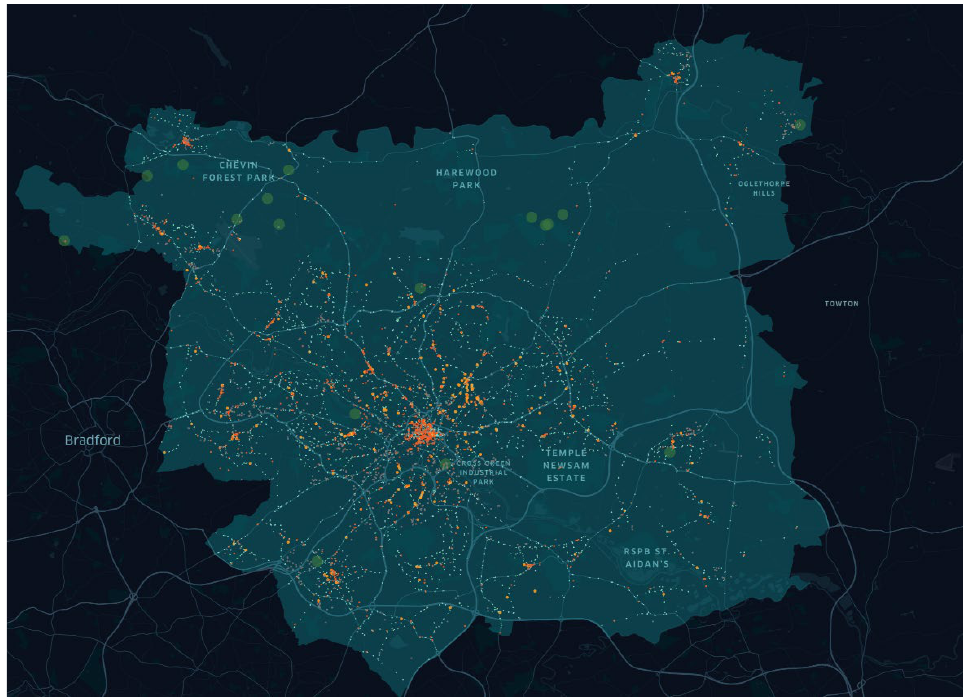
Figure 2. The Points of Interest in Leeds.